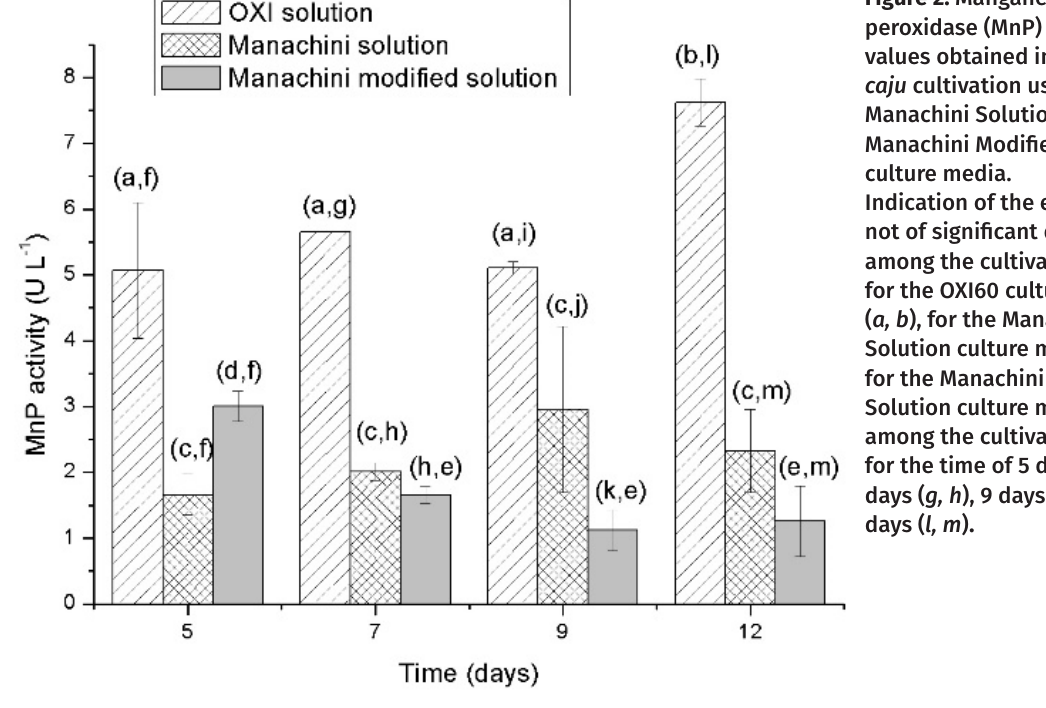
Figure 2. Manganese peroxidase (MnP) mean values obtained in P.